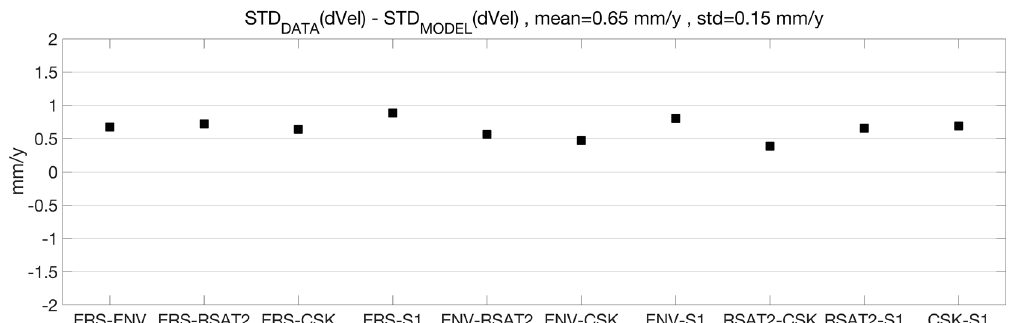
Figure 7. Difference between the standard deviation of the PS velocities difference from real data (Table 4), and the same standard deviation predicted by the model.